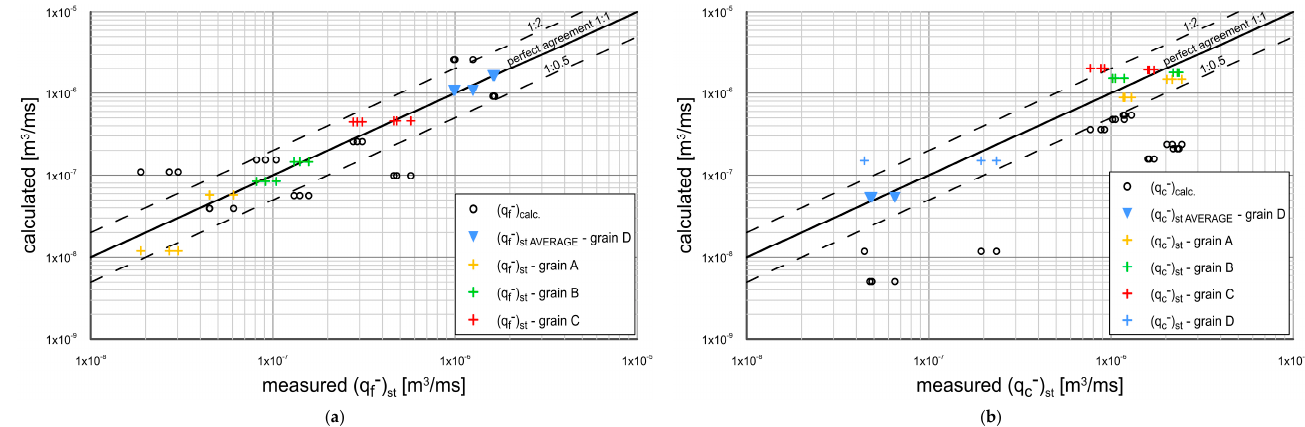
Figure 11. Comparison of calculated and measured transport during the trough q - in ( a ) fine fractions q − and ( b ) coarse fractions q − c f